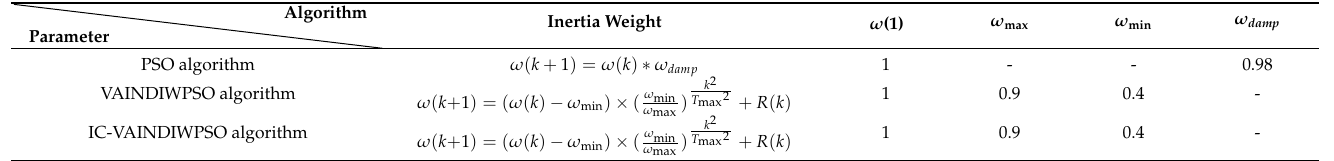
Table 4. The inertia weight formula and parameters of the three algorithms.